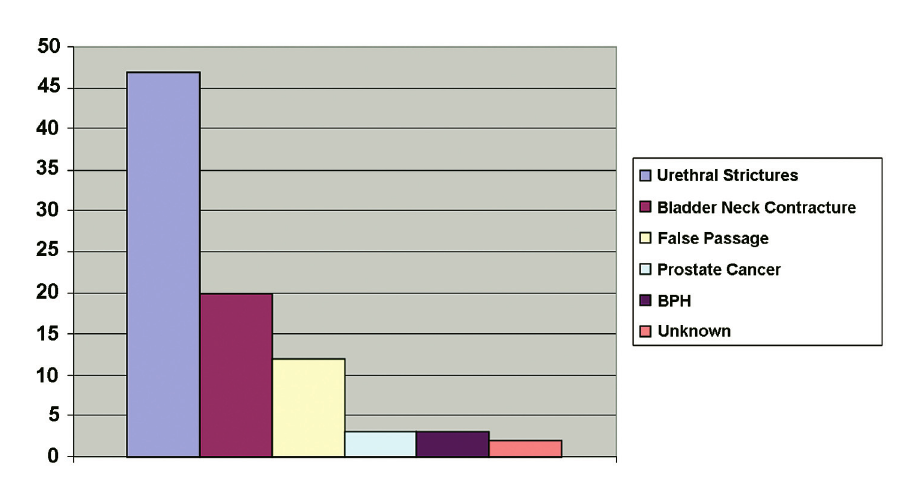
Figure 1 – Most common causes of difficult urethral catheterization*. * Pooled cases from Beaghler’s et al. (4), Freid’s et al. (6) and Mistry’s et al. (12) series. Included are the 54 patient from Beaghler’s series all of which underwent flexible cystoscopy, and the 13 patient in Mistry’s series that underwent flexible cystoscopy. Twenty pa - tients from Freid’s series were also included, but it was not mentioned in the article how the cause of difficult urethral catheterization was found in these